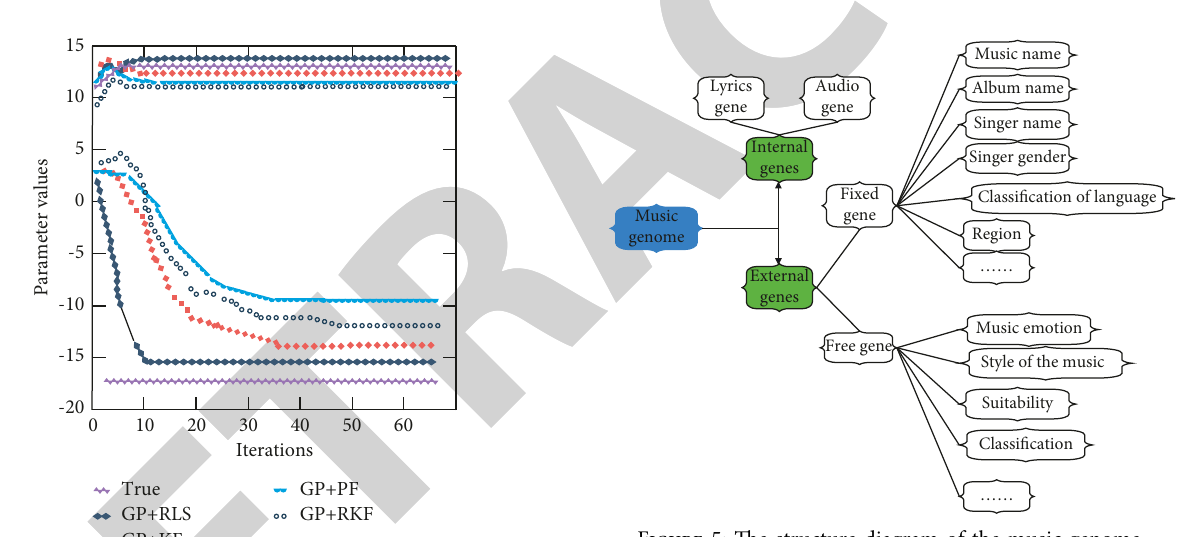
Figure 3: Convergence of parameter estimation of the E-CELL model under Laplace noise.